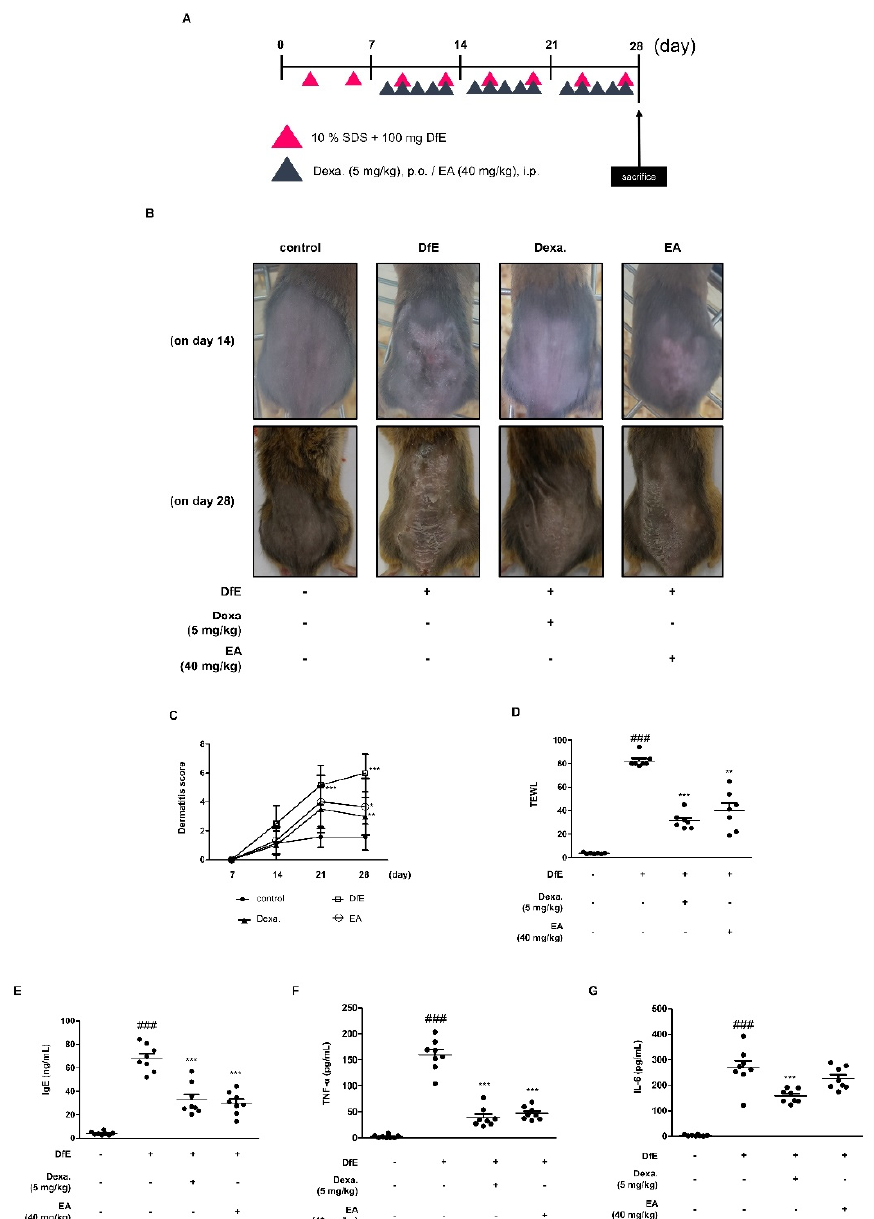
Figure 4. Effects of EA on DfE-induced AD-like skin lesions in NC/Nga mice. ( A ) Experimental scheme for the induction of AD and treatment of EA in NC/Nga mice. ( B ) Comparison of DfE-induced dermatitis in NC/Nga mice after EA (40 mg/kg/day) intraperitoneal administration. Representative photographs of dorsal regions of the mice from each group 14 and 28 days after AD induction. ( C ) Dermatitis scores over 4 weeks. The dermatitis scores were determined as the sum of scores graded as 0 (none), 1 (mild), 2 (moderate), or 3 (severe) for each of the four symptoms; erythema/hemorrhage, scarring/dryness, edema, and excoriation/erosion. ( D ) Transepidermal water loss (TEWL) was measured with a gpskin barrier light on day 28 after AD induction. ( n = 7) ( E ) Serum IgE, ( F ) serum TNF- α , and ( G ) serum IL-6 levels were measured by ELISA ( n = 8). Data are expressed as the mean ± standard deviation (SD). * p < 0.05, ** p < 0.01 and *** p < 0.001 versus the only DfE-treated group, ### p < 0.001 versus the control group by ANOVA and Dunnett’s post-hoc test.